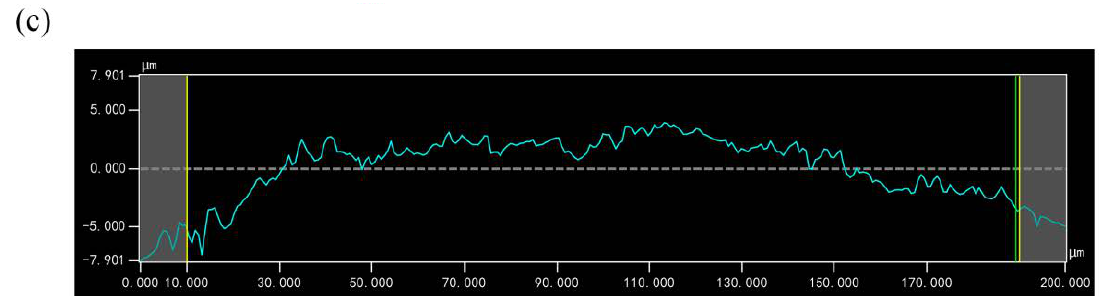
Figure 7. ( a ) 3D topography of bulging samples; ( b ) measurement value of surface roughness of bulging samples; ( c ) roughness curve.